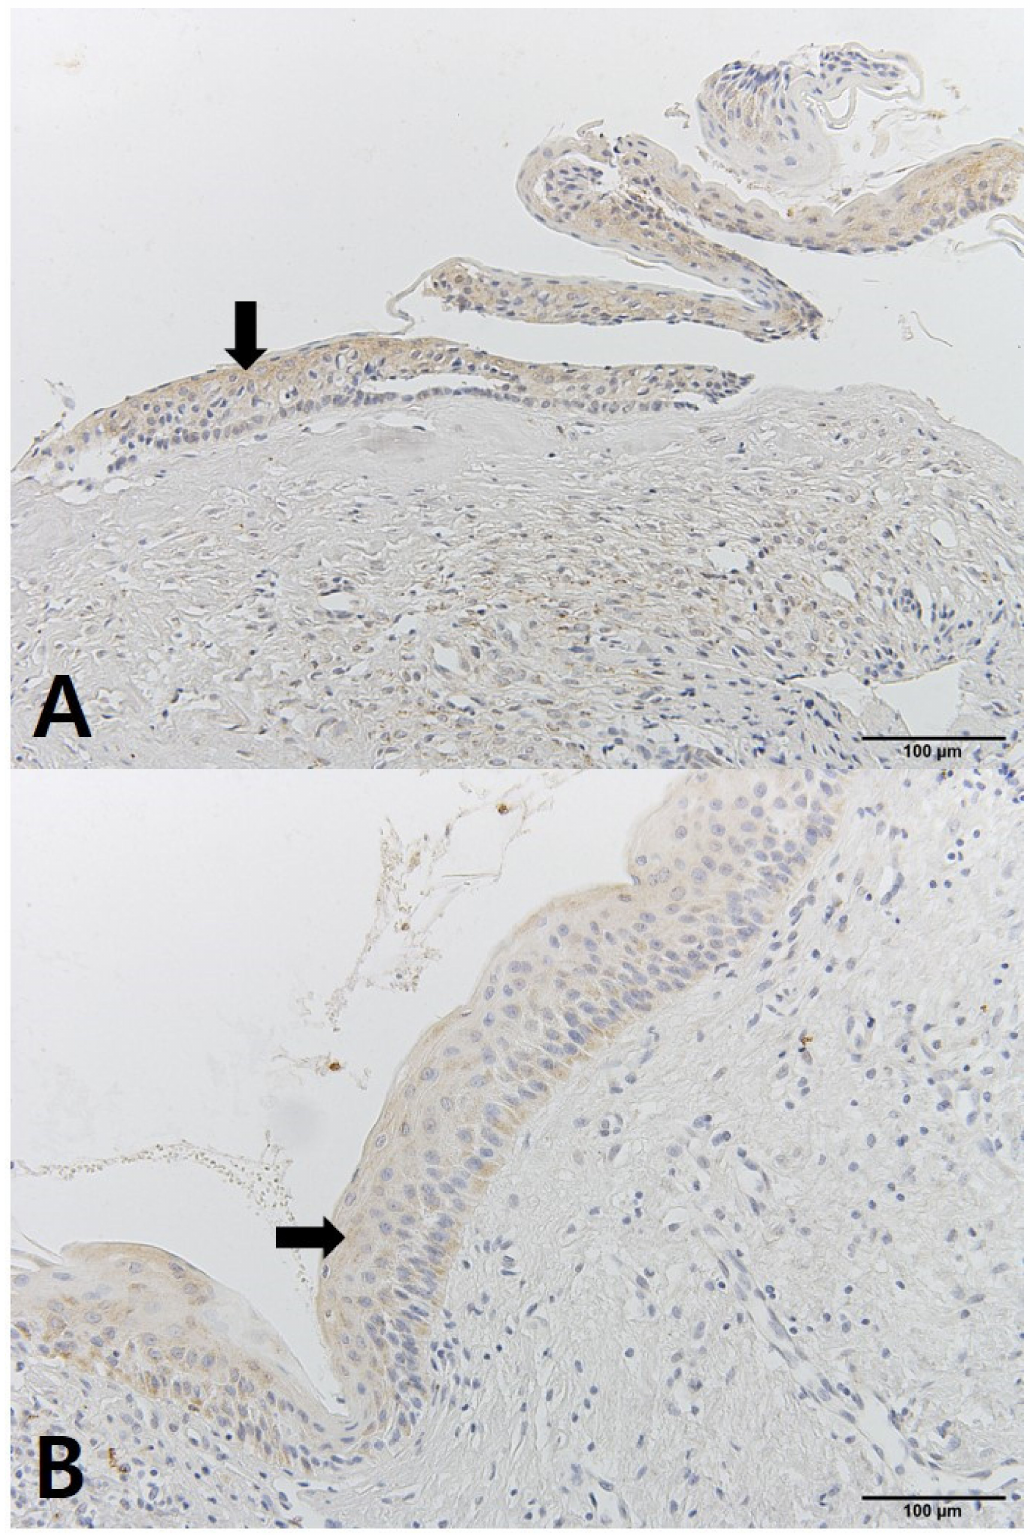
Figure 9. IHC staining of SMO: ( A ) tissue obtained at decompression; ( B ) tissue obtained